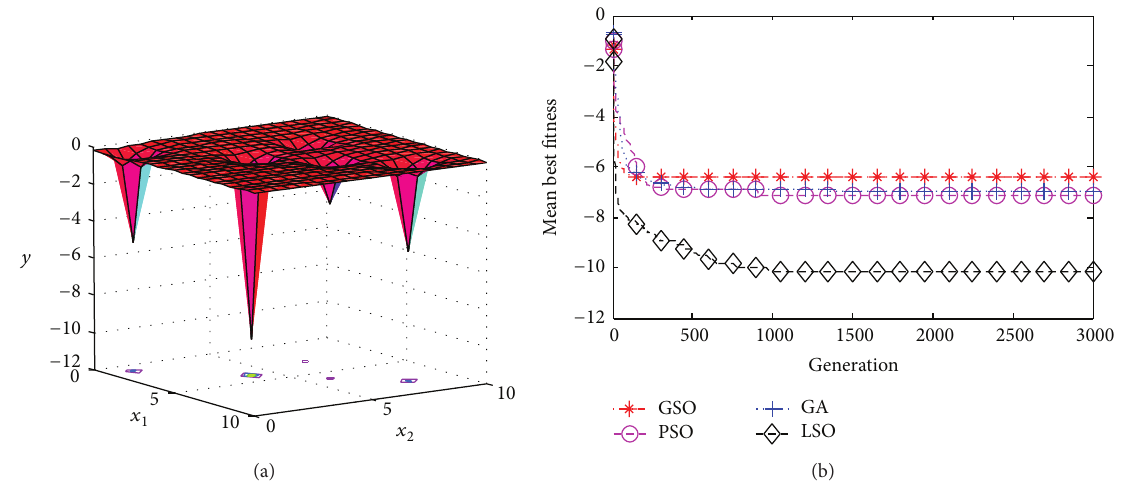
Figure 6: Function 𝑓 21 . (a) Function graphs with a dimension of 2 and (b) convergence results of all algorithms.